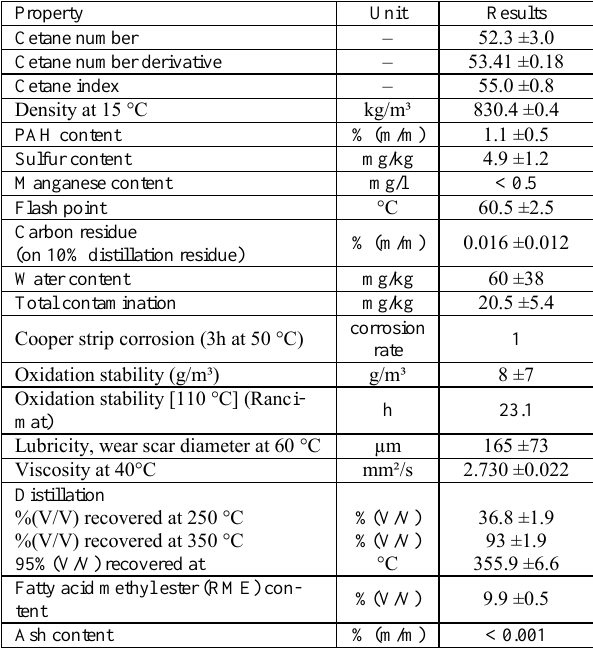
Table 1. Physical and chemical properties of B10 diesel